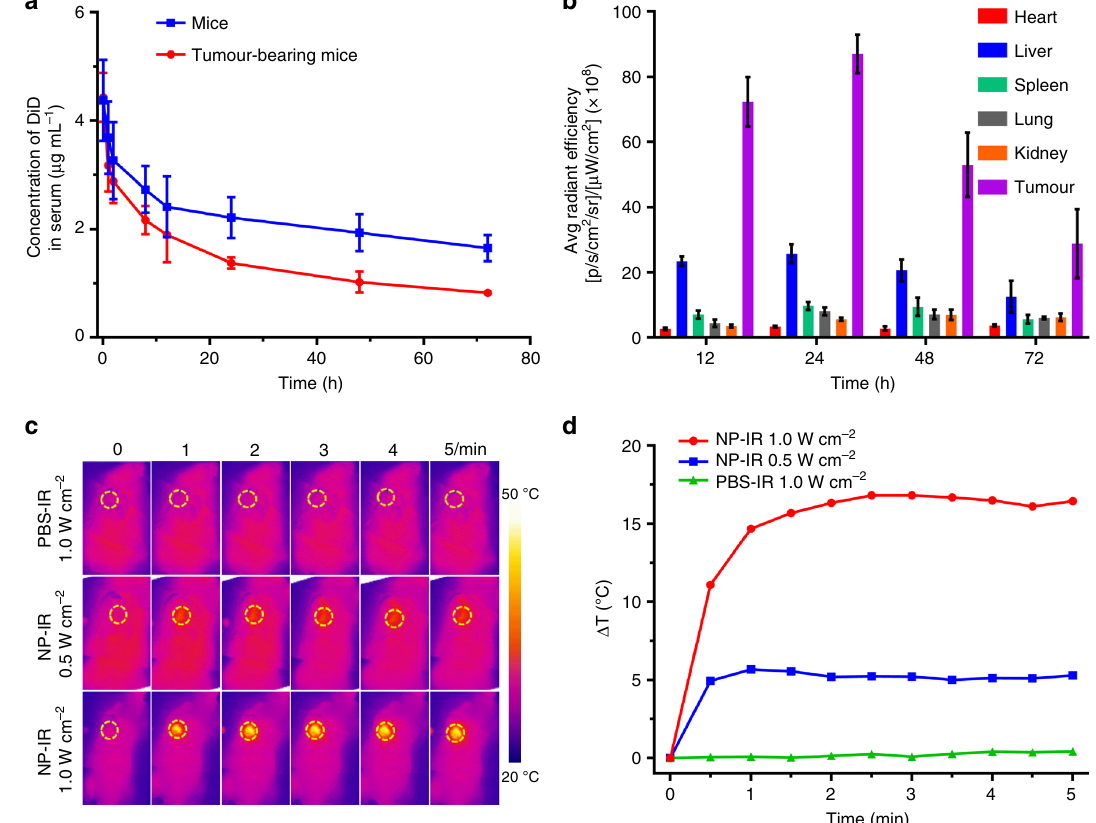
Fig. 4 In vivo performance of NP PPBBT nanoparticles on tumours. a Blood DiD concentration vs . time curves in healthy mice or orthotopic EMT-6 breast tumour-bearing mice intravenously injected with NP PPBBT /DiD at a DiD dose of 0.25 mg kg − 1 ( n = 3 for each group). b Quanti fi cation of DiD fl uorescence from the major organs (heart, liver, spleen, lung, kidney, and tumours) in orthotopic EMT-6 tumour-bearing mice sacri fi ced at 12, 24, 48 or 72 h post injection of NP PPBBT /DiD at a DiD concentration of 0.25 mg kg − 1 . c , d IR thermal images (the tumours were indicated by yellow dashed circles) ( c ) and tumour temperature evolutions ( d ) of orthotopic EMT-6 tumour-bearing mice after intravenous injection of PBS or 5 mg kg − 1 NP PPBBT under 808 nm laser irradiation at 0.5 or 1.0 W cm − 2 for 5 min. NP-IR: NP PPBBT plus laser irradiation; PBS-IR: PBS plus laser irradiation. Results are presented as mean ± S.D., n